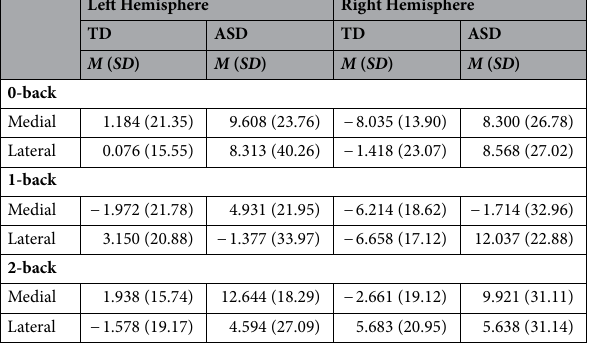
Table 5. Mean changes in oxyhaemoglobin concentration (Beta values) during the n-back task in TD (n = 24) and ASD (n = 22)